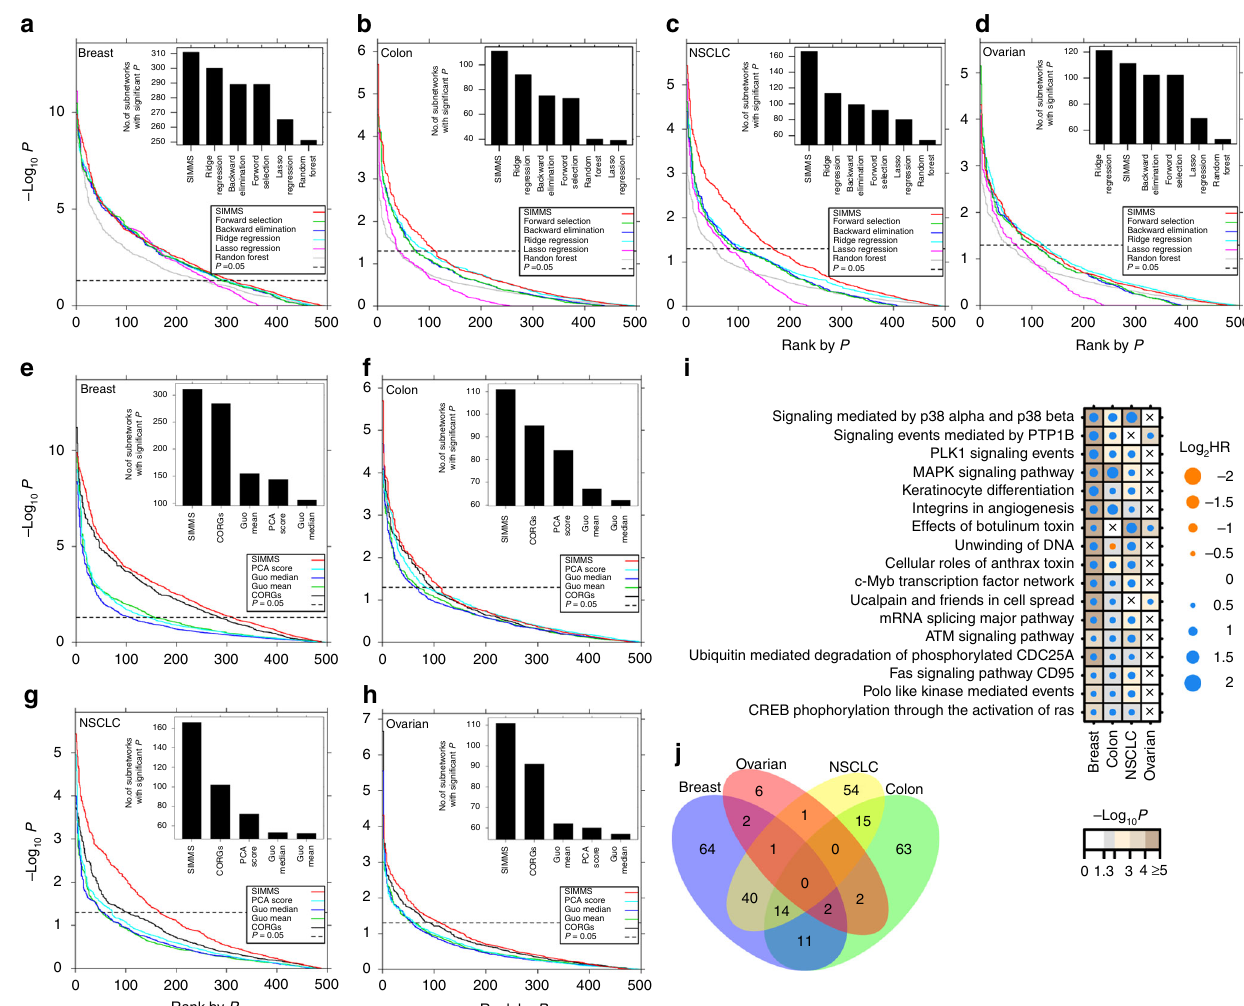
Fig. 1 Benchmarking prognostic subnetworks. a Comparison of prognostic ability of subnetworks in validation sets of breast cancer using SIMMS and fi ve machine learning algorithms. For each algorithm, Wald P values were ranked in increasing order. The number of validated subnetworks identi fi ed by each algorithm ( P < 0.05, above horizontal dashed line) are shown as barplots. b – d Same visualization as ( a ) using data for colon, NSCLC and ovarian cancers. e Comparison of SIMMS against other pathway/subnetwork scoring methods. For each method, ranked P values and total number of signi fi cant subnetworks are shown following prognostic assessment in breast cancer validation sets. f – h Same as ( e ) using data for colon, NSCLC and ovarian cancers. i Dot plot of univariate hazard ratios and P values (Wald-test) for each of the top n subnetworks signi fi cantly associated with patient outcome (|log 2 HR| > 0.584, P < 0.05) in at least 3/4 cancer types. A Cox proportional hazards model was fi tted to dichotomized risk scores across the entire validation cohort. Crosses represent absence of a module from a particular cancer type. j Overlap of candidate subnetwork markers across breast, colon, NSCLC and ovarian